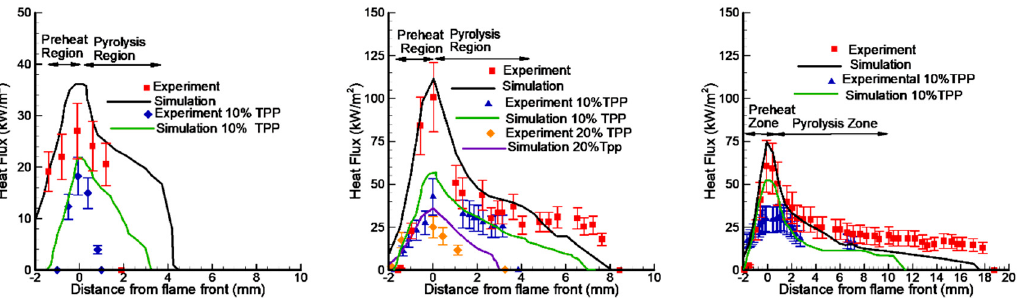
Figure 14. Comparison of the experimental and numerical distribution of conductive heat flux across the combustion zone of PMMA slabs of 1.5 mm, 4.95 mm, and 9.6 mm thicknesses without TPP (red symbols) and with 10%TPP (blue symbols) and 20%TPP (orange symbols).